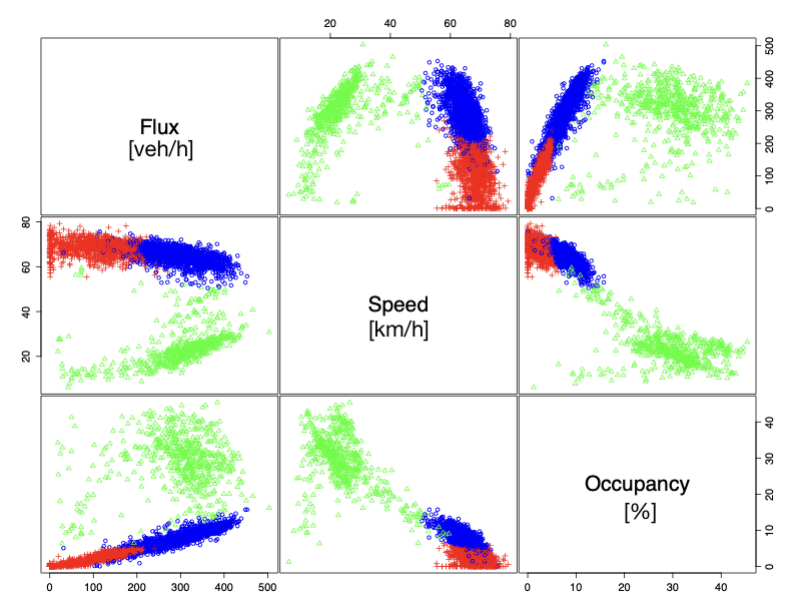
Figure A3. Pairs plot of clustered Las Vegas